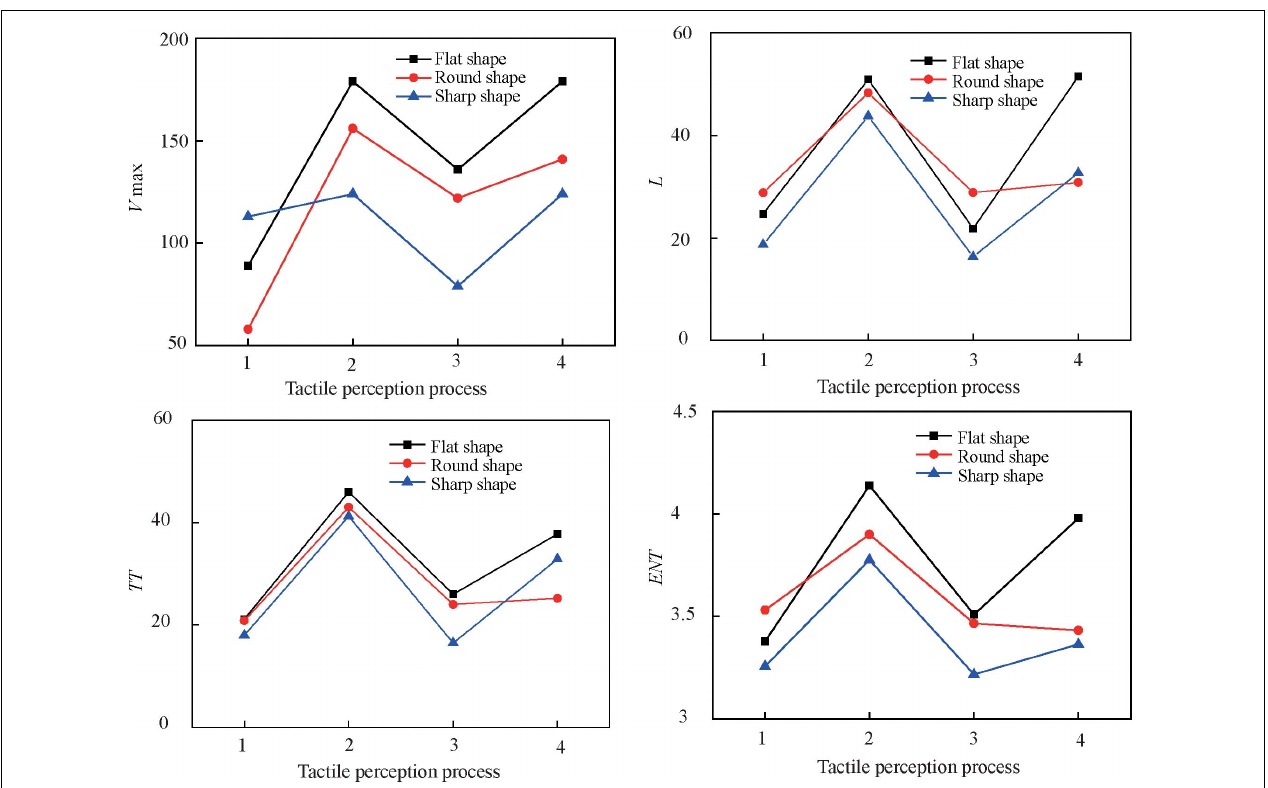
FIGURE 7 | Parameters of recurrence quantification analysis. (1) – 400–0 ms, (2) 0–500 ms, (3) 500–1000 ms, and (4) 1000–1600